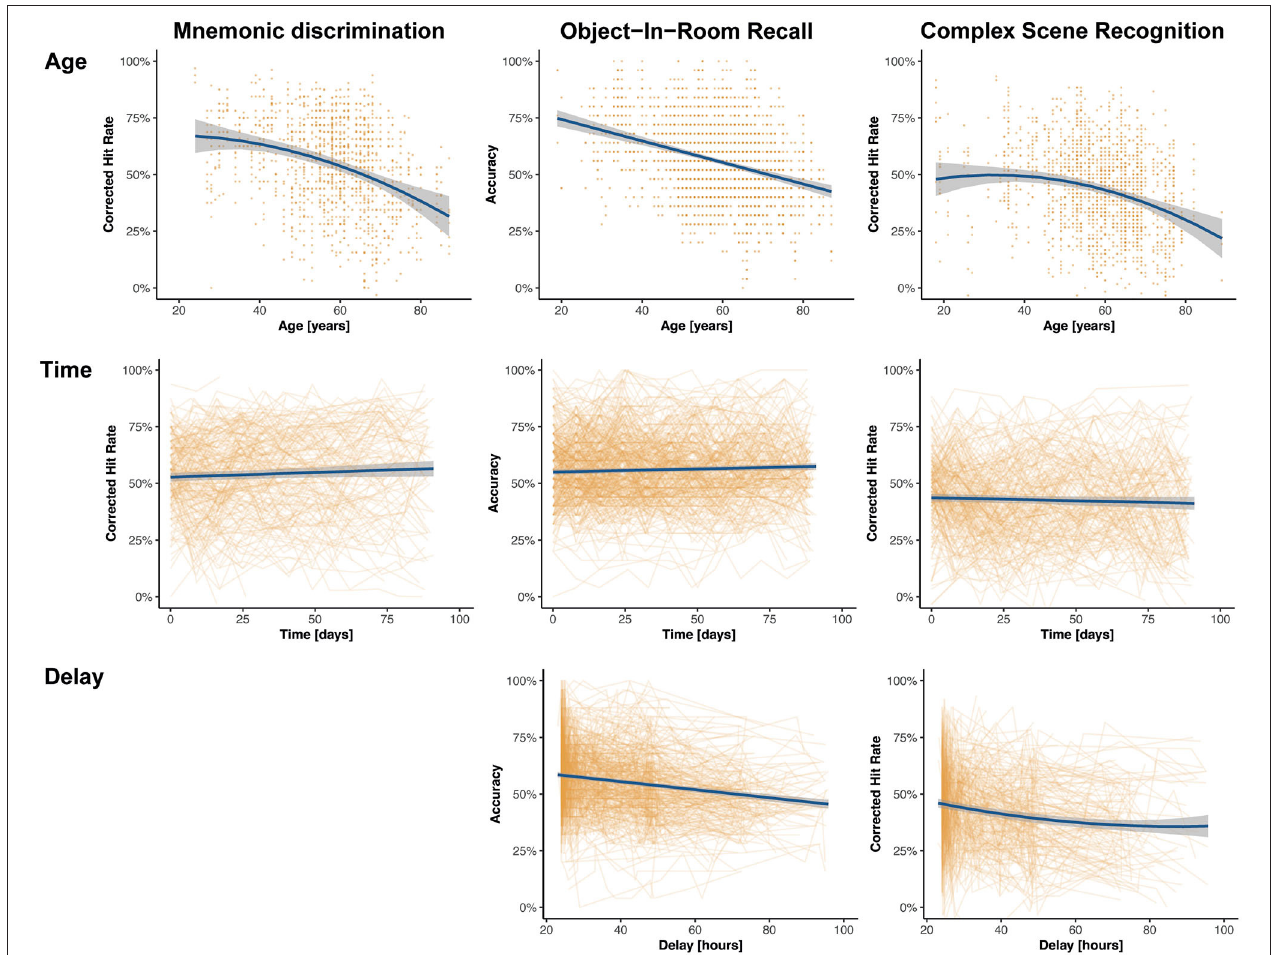
FIGURE 4 | Effects of interest of linear-mixed effects models across memory paradigms. The model predictions are shown in blue, and the non-adjusted original data points are shown in orange. The top panel shows the effect of age on memory performance where higher age is associated with worse memory performance across all paradigms. The effect is linear in ORR, quadratic in CSR, and trending quadratic in MDT-OS. The middle panel shows the effect of time since baseline on memory performance across all tasks, suggesting minor linear practice effects for MDT-OS und ORR, and no practice effects for CSR. The bottom panel shows that with longer delays between encoding and retrieval, performance gets worse in ORR and CSR. Note that MDT-OS is a continuous recognition paradigm, i.e., encoding and retrieval are not separated across the two phases, thus, not surprisingly the delay does not affect